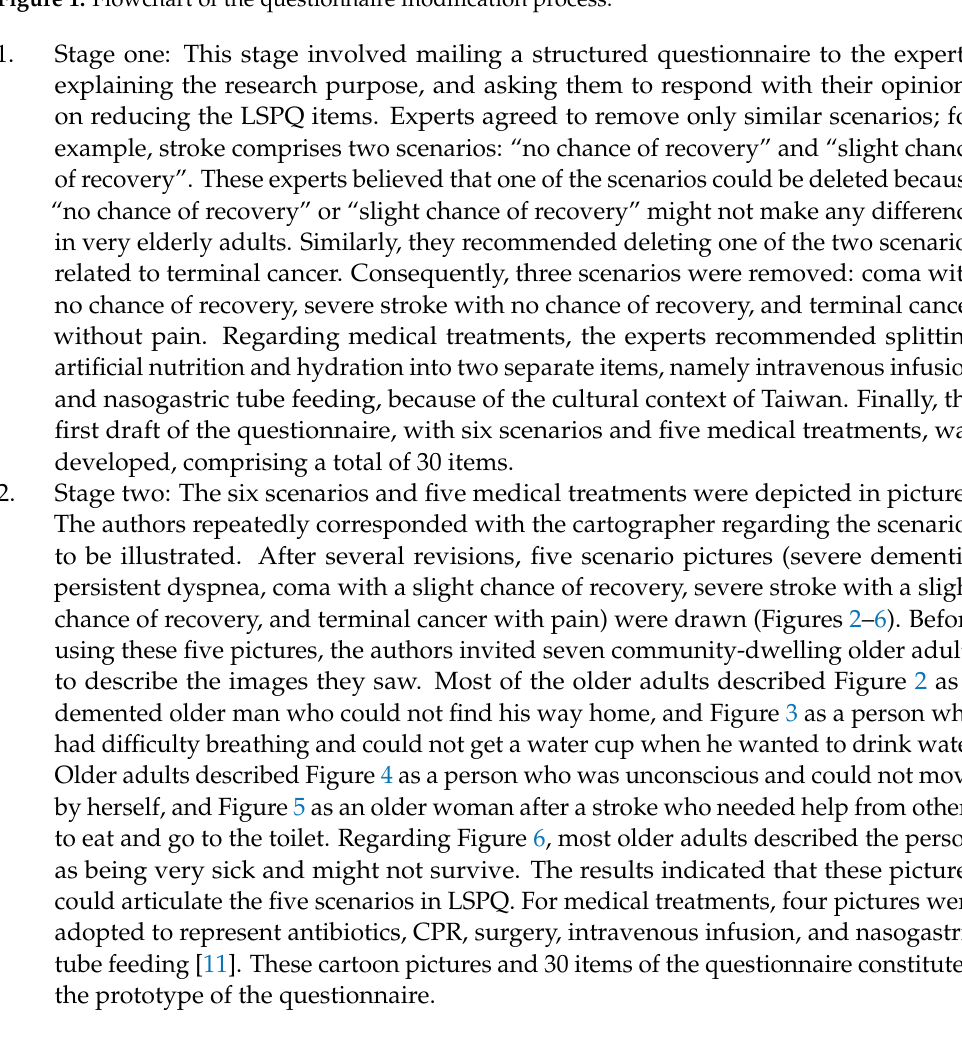
Figure 1. Flowchart of the questionnaire modification process.